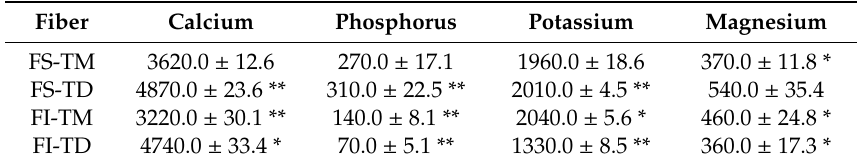
Table 2. Mineral contents in the soluble and insoluble dietary fiber extracted from O. ficus indica cladodes at di ff erent maturity stages (mg / 100